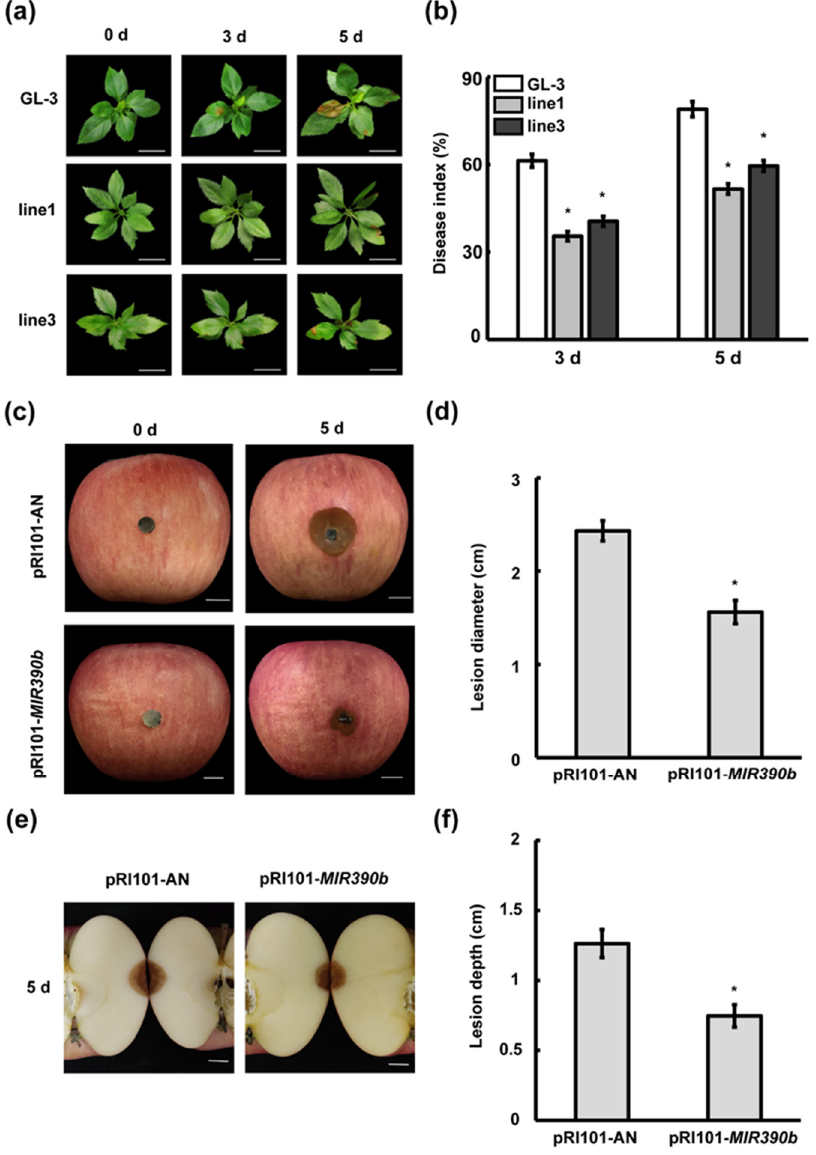
Figure 5. Apple MIR390b enhances resistance to C. gloeosporioides in leaves and fruit. ( a ) Leaf phenotype of ‘GL-3 ′ and MIR390b -overexpressing plants under C. gloeosporioides infection, white bars = 2 cm. ( b ) Disease index of ‘GL-3 ′ and MIR390b -overexpressing plants under C. gloeosporioides infection. The vertical bars represent SDs ( n = 3). ‘*’ represents p < 0.05 (Student’s t -test). ( c ) Phenotype of apple fruit transiently expressing pRI101- MIR390b and empty vector (control) under C. gloeosporioides infection, white bars = 1 cm. ( d ) Lesion diameter of apple fruit after infection with C. gloeosporioides for 5 d. The vertical bars represent SDs ( n = 3). ‘*’ represents p < 0.05 (Student’s t -test). ( e ) V-shaped necrotic tissue caused by inoculation of C. gloeosporioides in wound, white bars = 1 cm. ( f ) Fruit lesion depth caused by wound inoculation of C. gloeosporioides . The vertical bars represent SDs ( n = 3). ‘*’ represents p < 0.05 (Student’s t